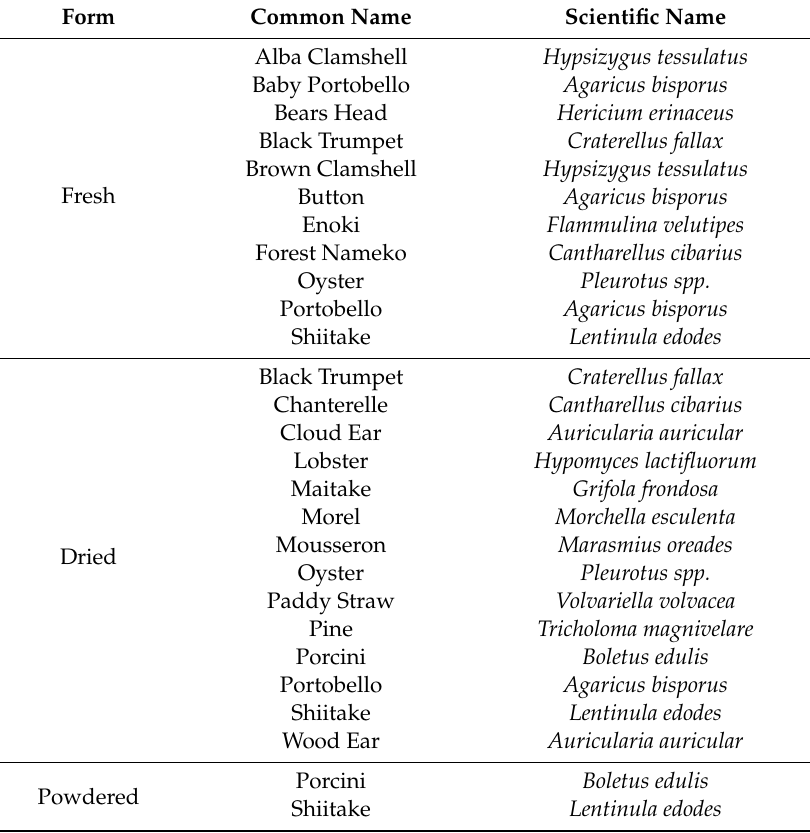
Table 1. Mushrooms used in the